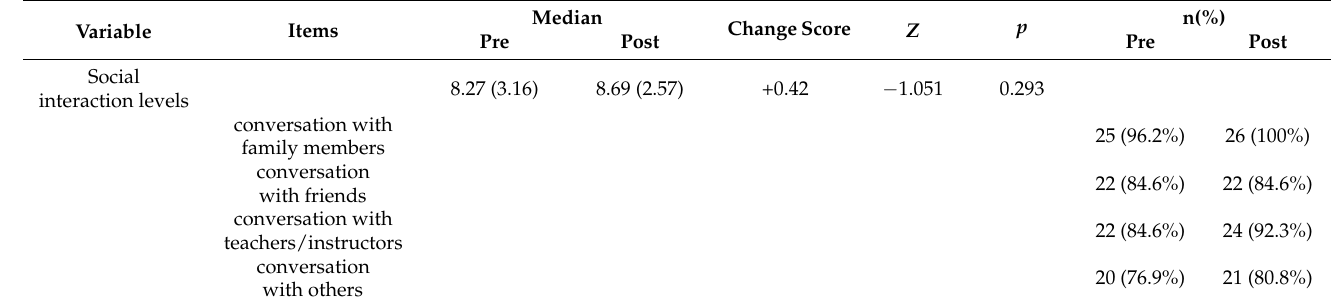
Table 3. Comparison of social interaction levels between before and after exercise program participation.